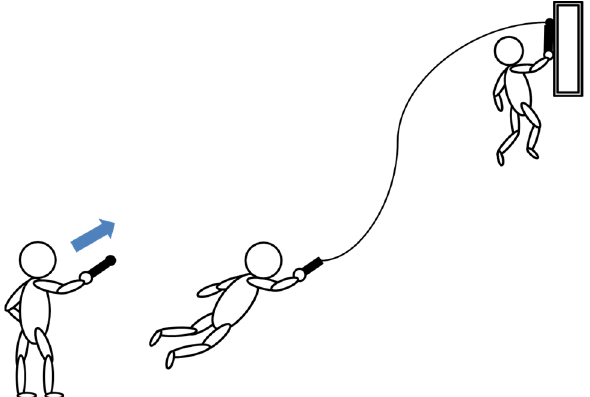
Figure 1. Overview of TSMD.